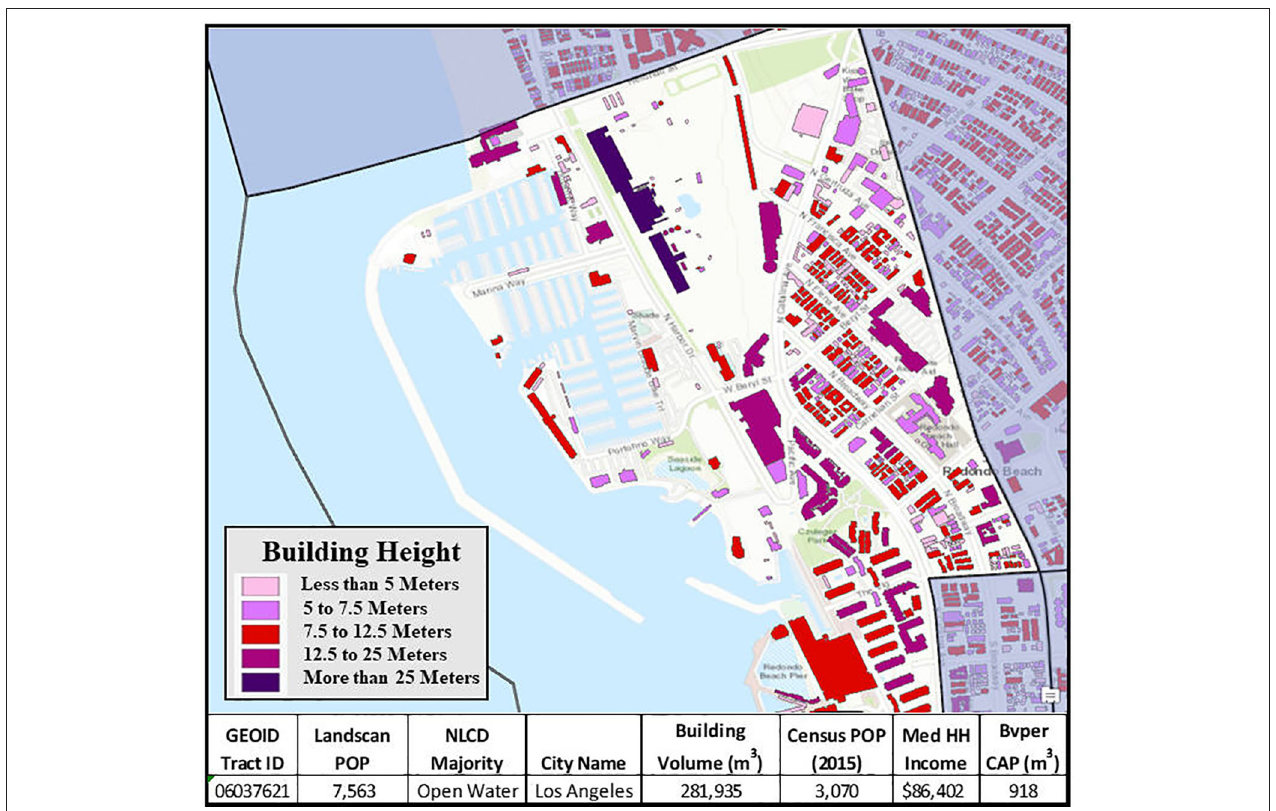
FIGURE 2 | Inset of Raw Building Volume Data for a single census tract representing Redondo Beach and Marina Del Rey in Los